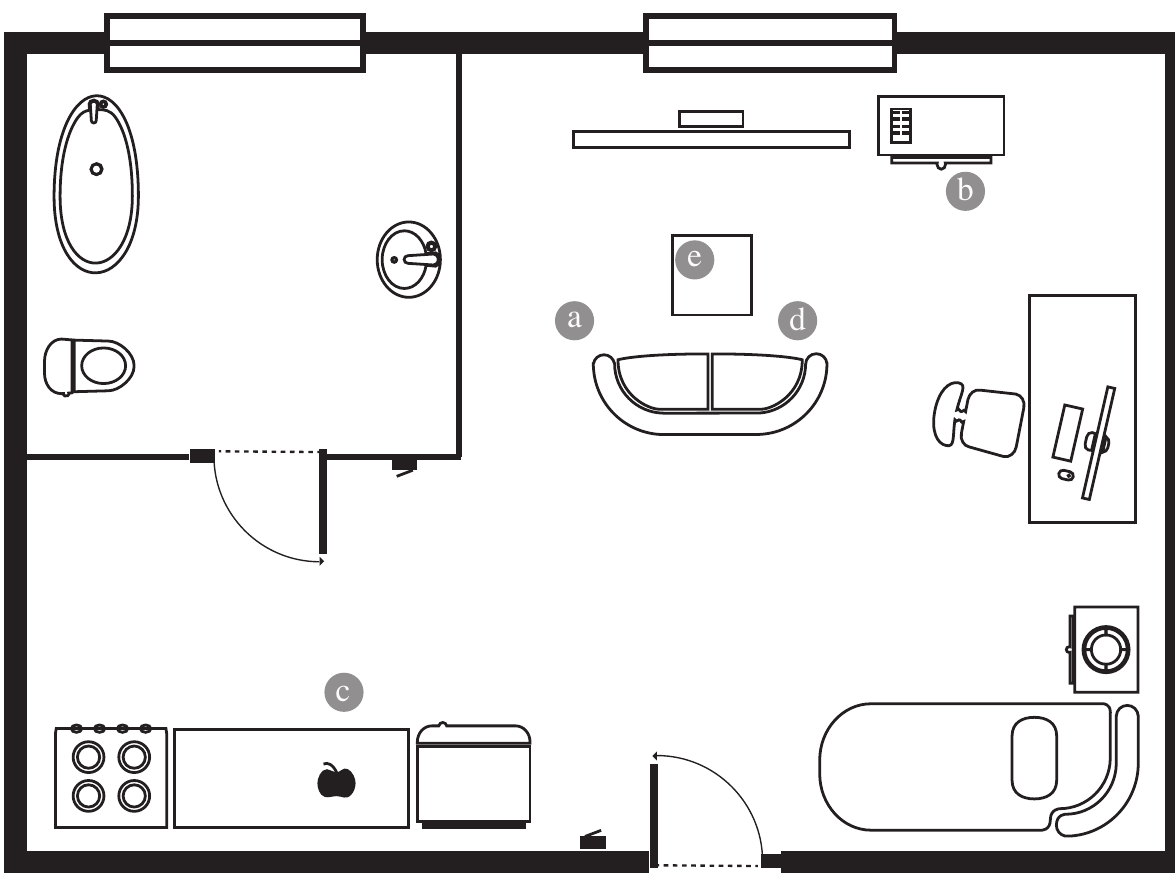
Figure 14. The apartment environment that was used to record the high-level scenarios. (a) The couch (start position). (b) TV table and remote positions. (c) Kitchenette and apple positions. (d) The couch (end position). (e) Coffee